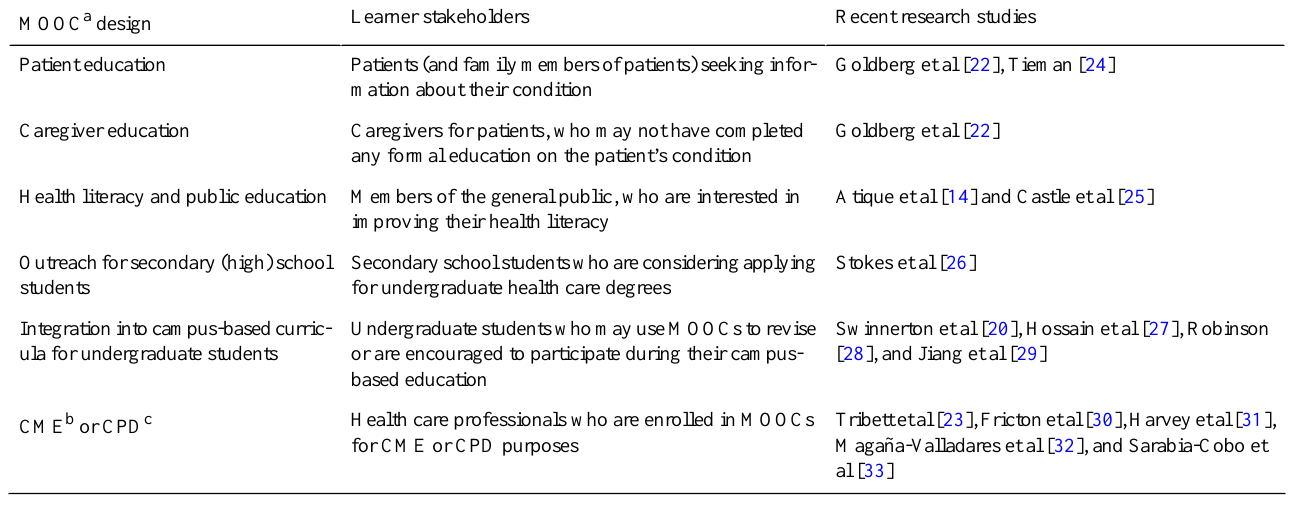
Table 1. Learner stakeholders who may benefit from health care massive open online